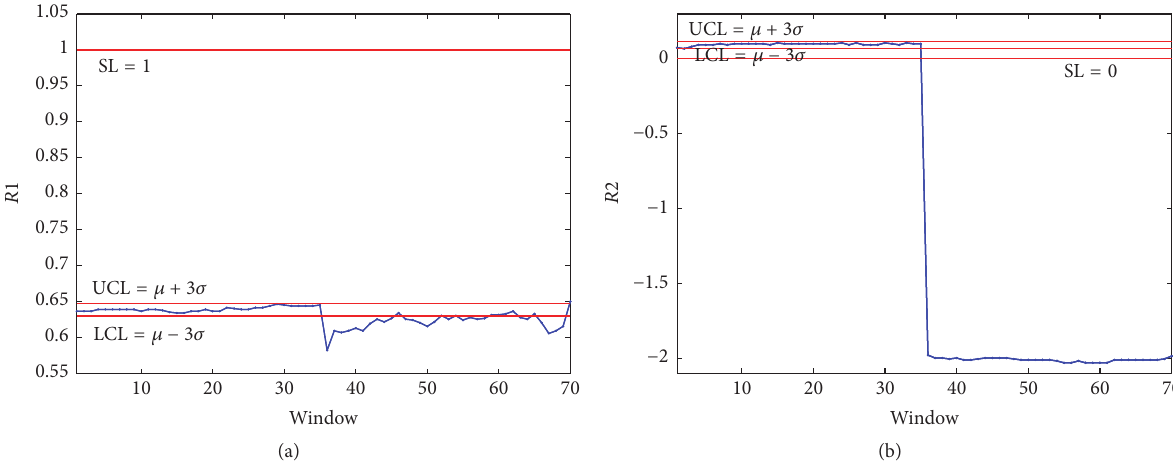
Figure 7: Stability monitoring with a process change 𝐺 𝑝 = (0.6 − 0.3𝑧 −1 )/(1 − 0.7𝑧 −1 ) → 𝐺 𝑝 = (0.6𝑧 −1 − 0.3𝑧 −2 )/(1 − 0.7𝑧 −1 )